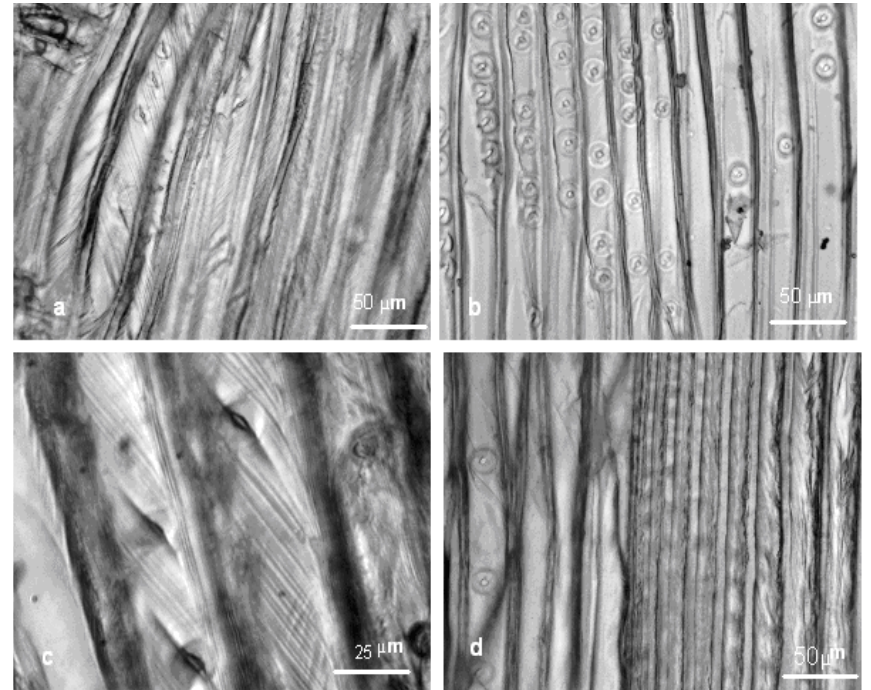
Fig. 2. Light microscope images of bordered pits in compression and opposite wood of Picea abies . Scarce and small bordered pits in compression wood (a) vs. larger and more numerous pits in opposite wood (b), Slit-like pit apertures of bordered pits in compres- sion wood (c); Compression wood tracheids beside normal wood ones in earlywood (d). Note that the bordered pits are obvious in normal wood but unclear in compression